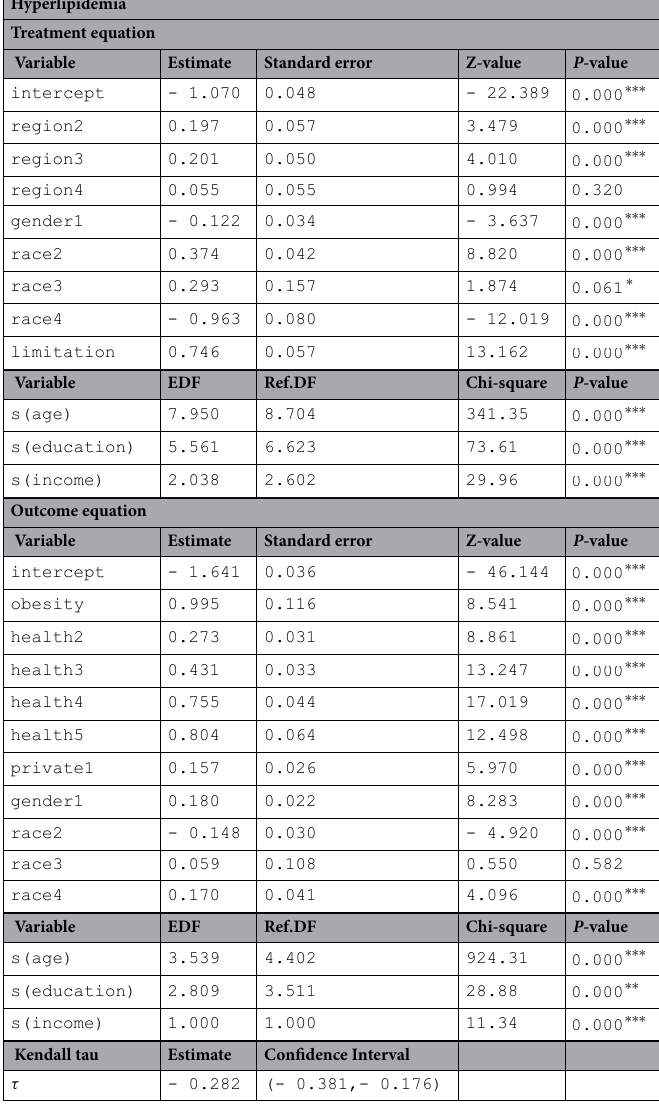
Table 5. Estimated coefficients and standard errors of the parametric and non-parametric components of the Plackett copula ( PL ) for the treatment and outcome equations for hyperlipidemia. The models were fitted using the “ probit - logit ” link functions combination. More details are given in Table